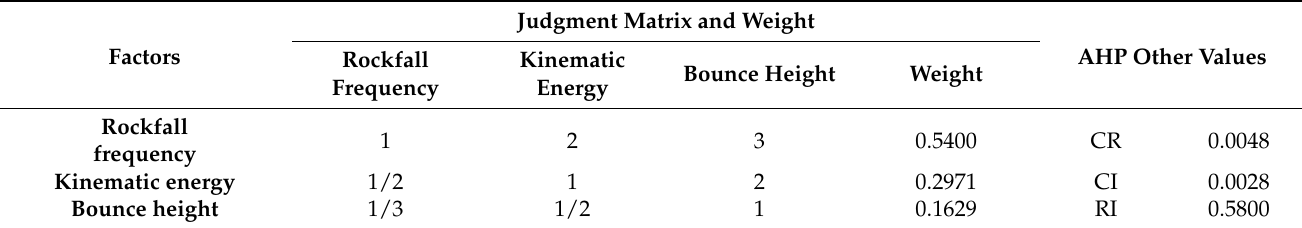
Table 8. The main parameters obtained based on the AHP